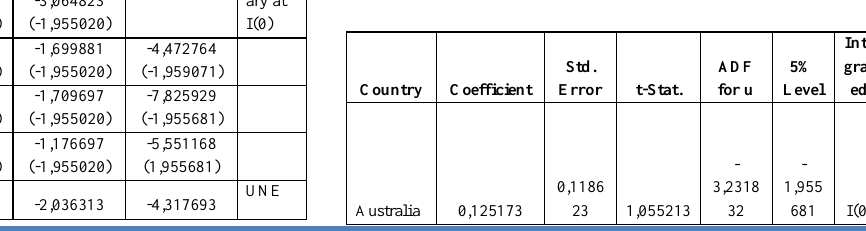
Engle-Granger cointegration test